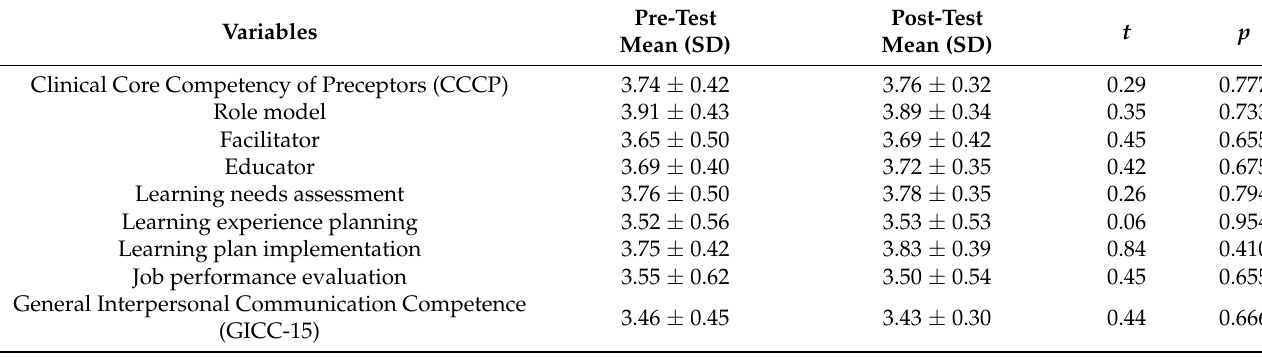
Table 2. Effects of PEP on the